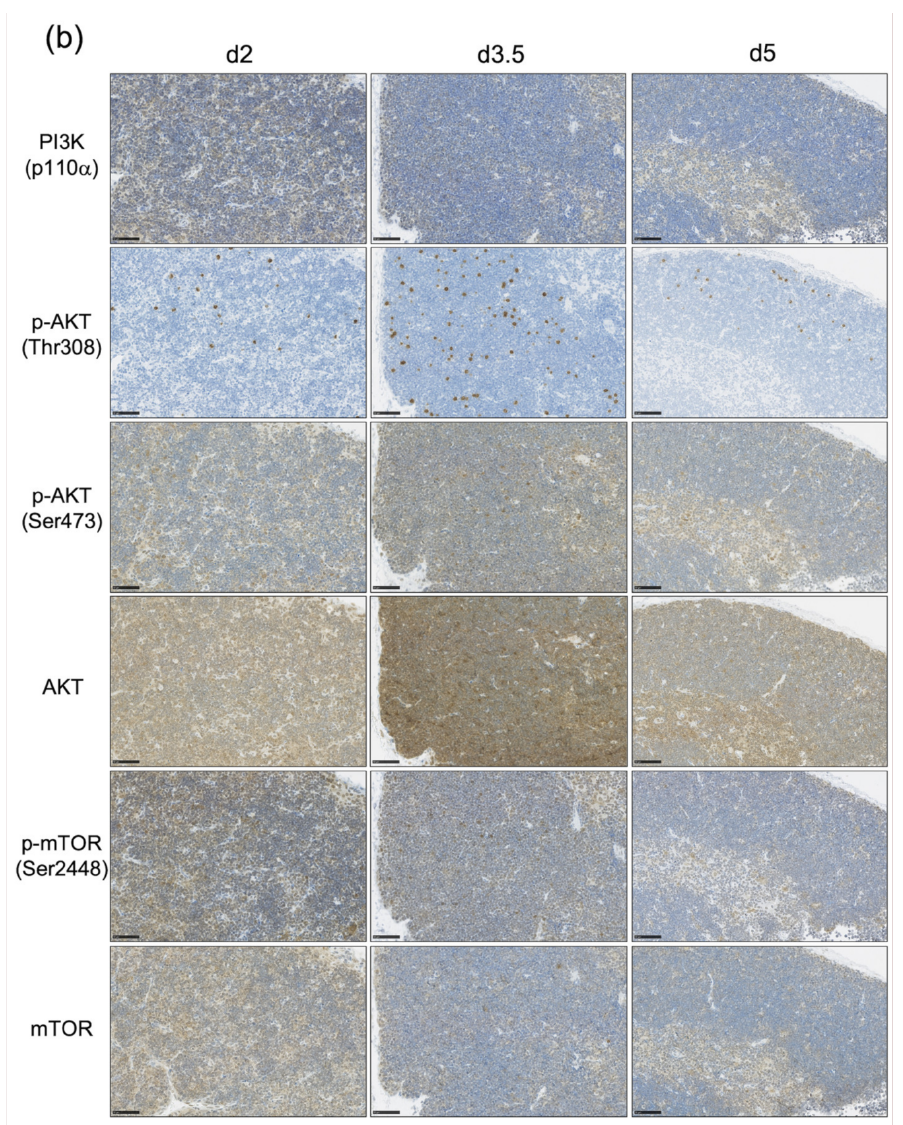
Figure 3. Immunohistochemical analysis of the expression of the PI3K-AKT-mTOR pathway- associated proteins during the first regeneration. The expression of PI3K (p110 α ), phospho-AKT (Thr308 and Ser473), AKT (pan), phospho-mTOR (Ser2448), and mTOR were analyzed to assess the activation of the PI3K-AKT-mTOR pathway in the thymus during the first regeneration phase. At least three immunostained images were acquired at the same time point, and representative images are shown. ( a ) Irradiated infants; ( b ) irradiated adults. All sections were counterstained with hematoxylin. Scale bar in all panels represents 50 µ